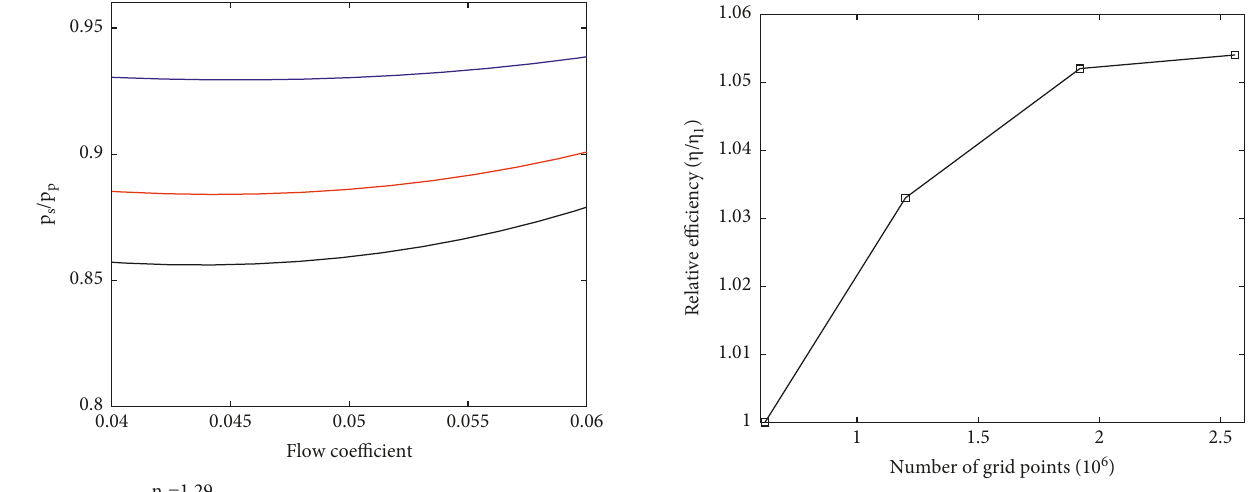
Figure 11: Grid sensitivity of the SNL supercritical CO